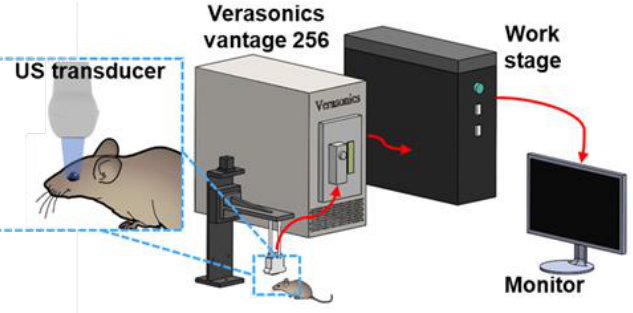
Figure 1. Schematic diagram of the ULM for microvessel imaging of the OCM.